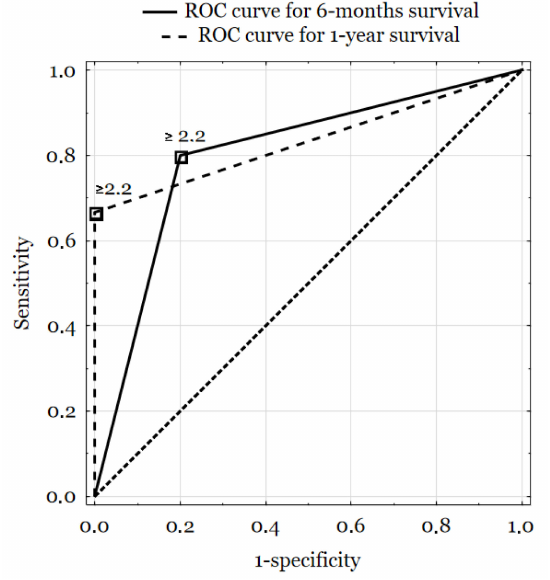
Figure 2. ROC curves for 6-months and 1-year survival, according to fT3/fT4 ratio status. The categorized FT3/fT4 ratio (<0.22 vs. ≥ 0.22) dichotomizes the study population into poor and good prognosis subgroups ( p = 0.035; OS medians, respectively: 3 and 14 months, Figure 3); other tested parameters do not present statistical significance. We also performed the Cox regression, presented in detail in Table 3. FT3/fT4 ratio was the only one of the analyzed linear parameters (age, TSH, fT3, fT4) which revealed to be a strong, independent prognostic factor for OS (HR = 0.13, p = 0.017). We also constructed s multivariate Cox model, where fT3/fT4 ratio ≥ 0.22 was the strongest independent predictor for OS (HR = 0.01, p = 0.004). Other significant predictors were preoperative CA-15.3 (HR = 1.18, p = 0.025) and Whipple’s procedure (HR = 0.01; p = 0.024).